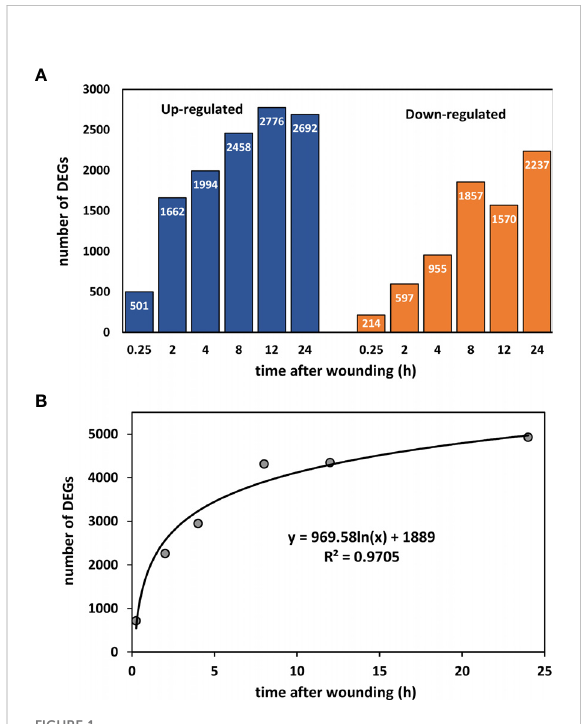
FIGURE 1 Number of differentially expressed genes (DEGs) between wounded and control roots as a function of time after wounding. (A) Up- and down-regulated DEGs after 0.25, 2, 4, 8, 12, and 24 h after wounding. (B) Effect of time after wounding on the total number of